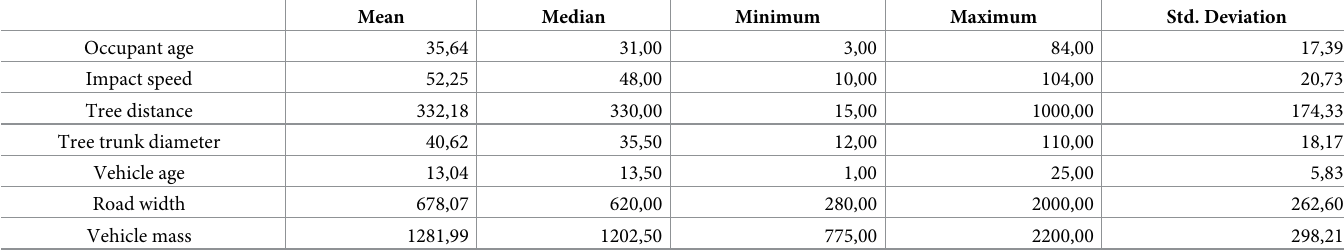
Table 2. Summary of continuous